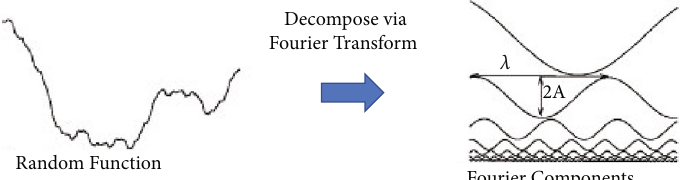
Figure 1: Schematic of surface pro fi le breakdown. Each component is characterized by its wavelength ( λ ), amplitude ( A ), and phase (relative position of the fi rst peak of the sinusoid to that of all others).